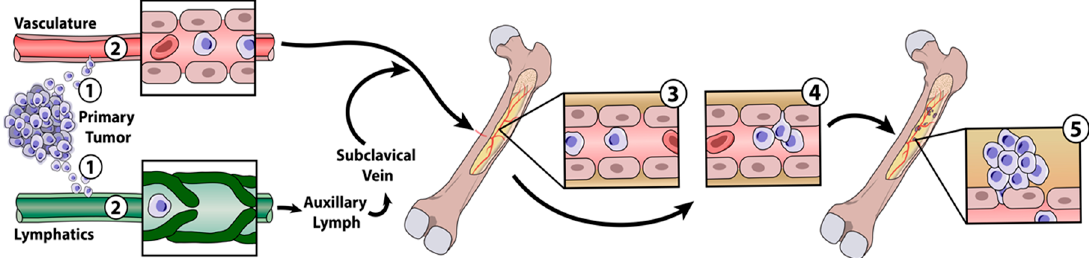
Figure 1. Mechanism of bone metastasis. ( 1 ) Cancer cells from primary tumor detach and invade surrounding tissue before ( 2 ) intravasation into the circulatory and lymphatic systems. Lymph, and the cancer cells within it, ultimately enters the bloodstream through the subclavian vein, via the thoracic ducts. Cancer cells that evade the immune system ( 3 ) translocate through capillaries in the bone where they ( 4 ) extravasate into the bone marrow to ( 5 ) establish metastatic sites.